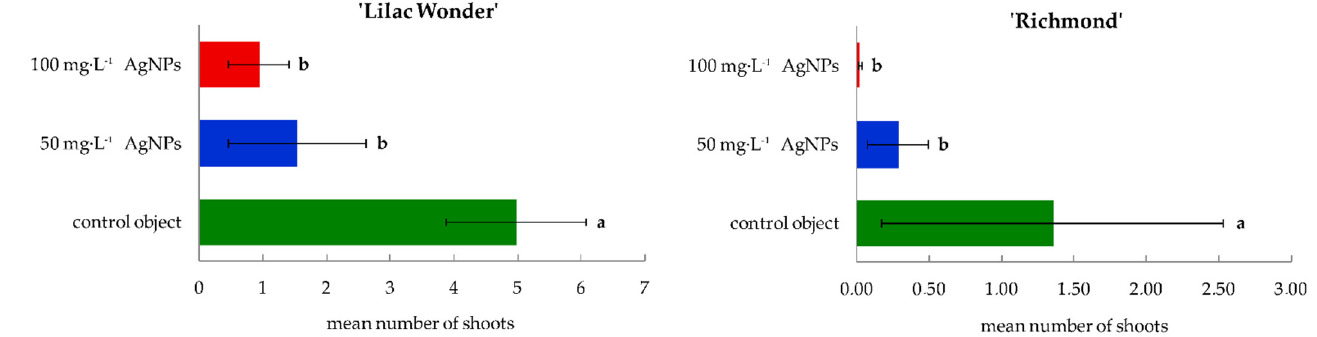
Figure 3. Mean number of adventitious shoots regenerated per one inoculated leaf explant in Chrysanthemum × grandiflorum ‘Lilac Wonder’ and ‘Richmond’ after 10 weeks of culture on the modified MS medium with 0.6 mg·L − 1 BAP and 2 mg·L − 1 IAA, depending on the AgNPs treatment (0–100 mg·L − 1 ). Means ± SD on graphs for each cultivar tested followed by the same letter do not differ significantly at p ≤ 0.05 (Tukey’s test).